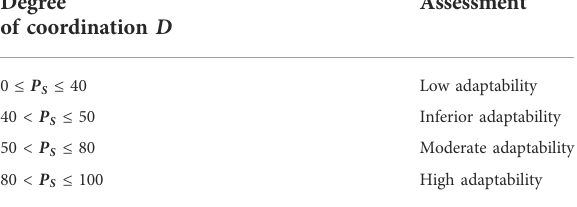
TABLE 6 Index evaluation criteria of the degree of